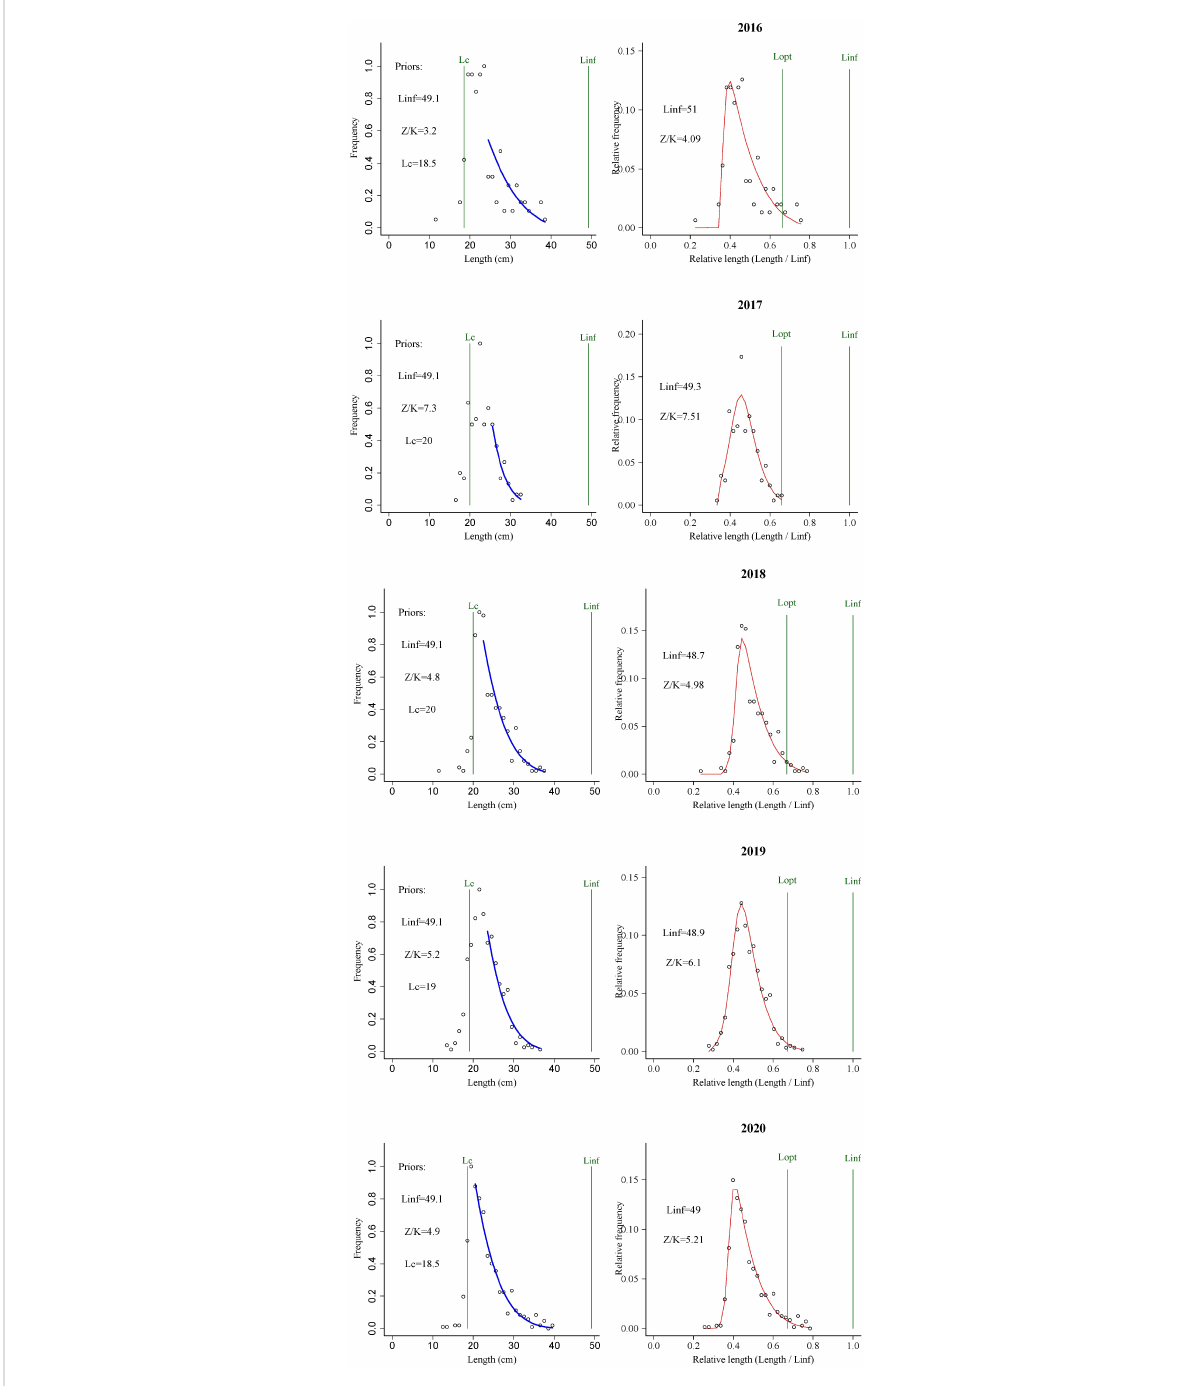
FIGURE 3 Assessment results of the length – based Bayesian (LBB) method for T. lepturus